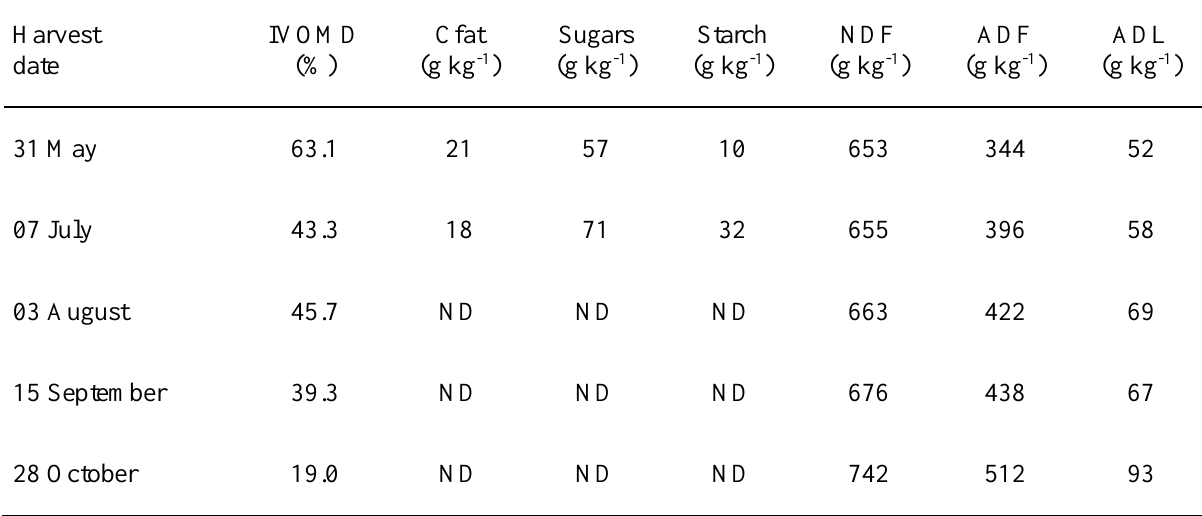
Table 3. Experiment I: Effect of harvest day on in vitro organic matter digestibility (IVOMD), and the dry matter contents of crude fat (Cfat), sugars, starch, neutral detergent fibre (NDF), acid detergent fibre (ADF) and acid detergent lignin (ADL) in T. latifolia biomass one year after planting. Each figure represents measurements from two different subplots, harvested for the first time in the growing season (2016). DM = dry matter; ND = not